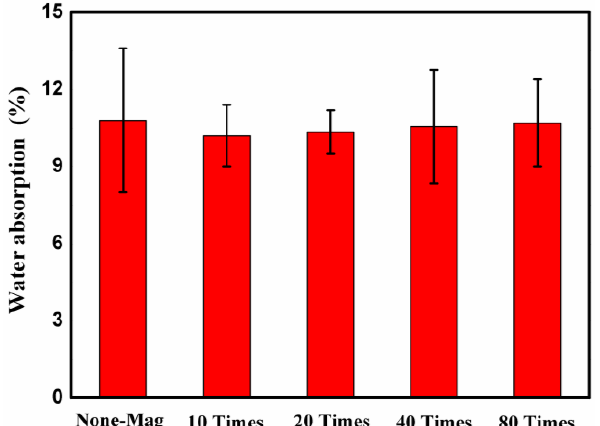
Figure 10. Water absorption of mixes prepared with regular tap water and magnetized water after 28 days of curing.